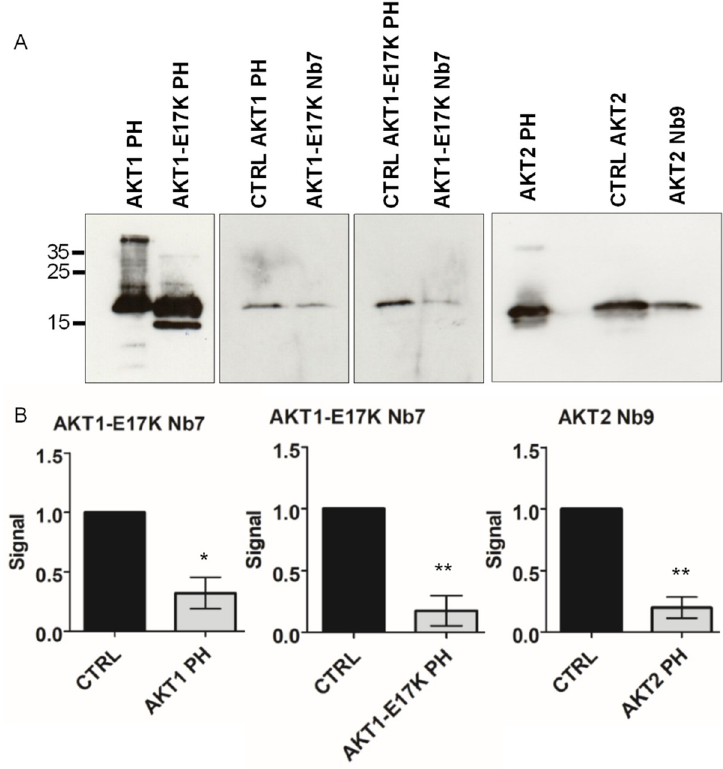
Fig 5. AKT Nanobodies interfere with AKT-PH—PIP3 interaction. (A) Western Blot of pull-down experiments using PIP 3 —coated beads and the AKT PH-domains. For each PH domain a positive control (CTRL) was included where the PH-domains were incubated with the beads without Nb. When the PH-domains were incubated with AKT1-E17K Nb7 or AKT2 Nb9 before PIP 3 -coated beads were added we observe a reduction in the signal for AKT1 PH- and AKT1-E17K PH- or AKT2 PH-domain respectively. Representative for three repeated experiments. � p �